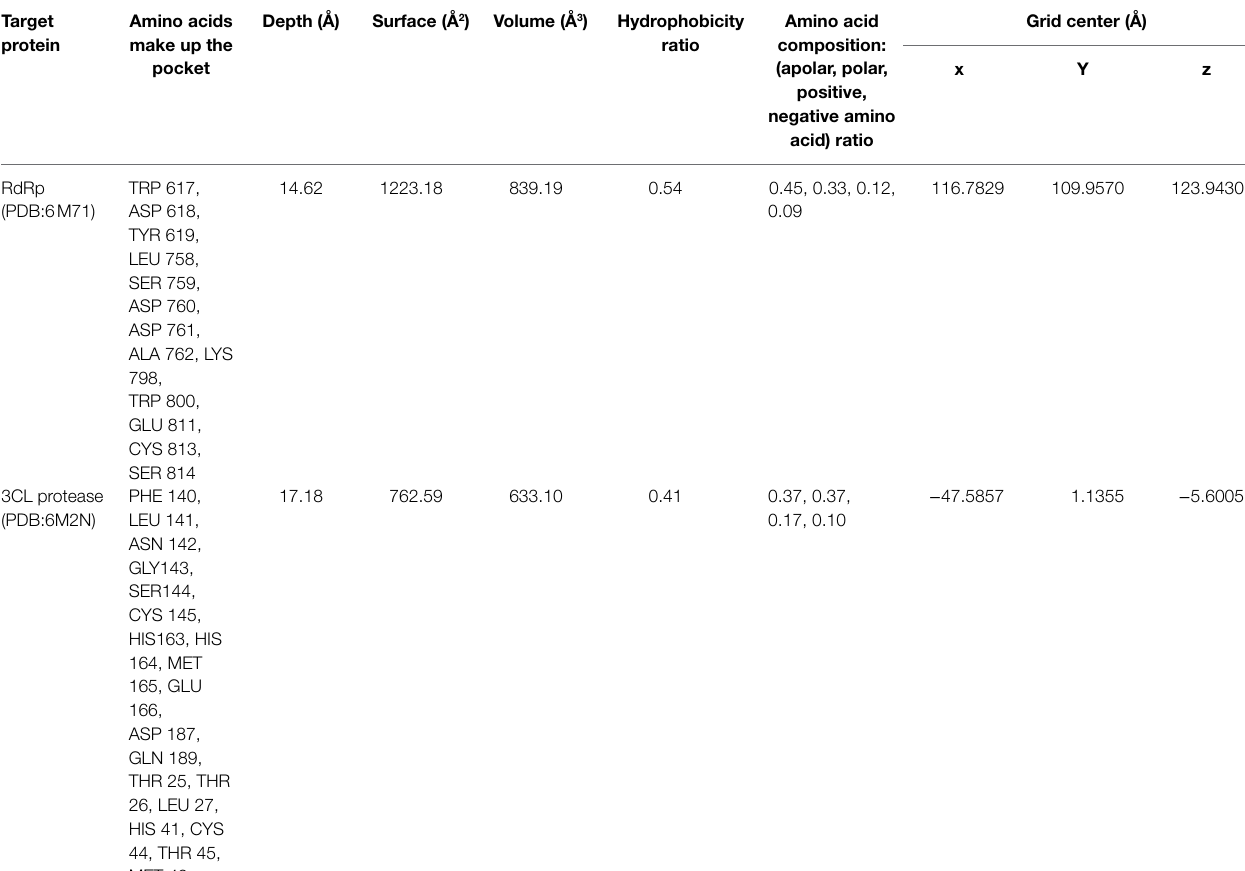
TABLE 1 | PrankWeb result summary of RdRp and 3CL protease of SARS-CoV-2. Target